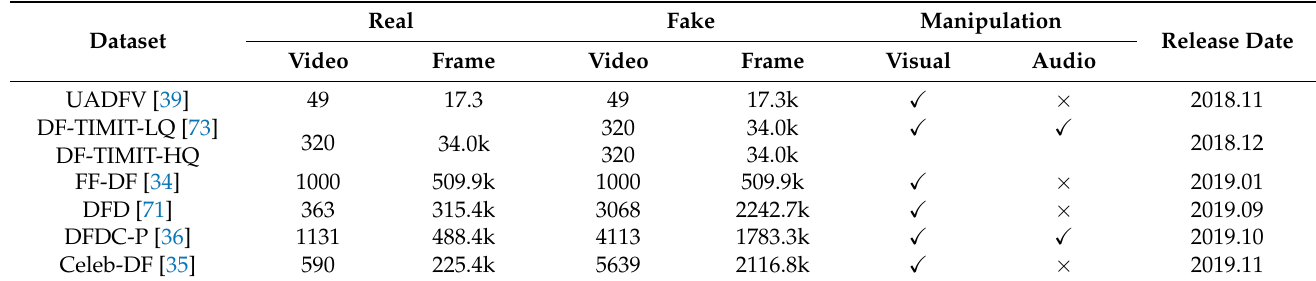
Table 1. Datasets Summary.